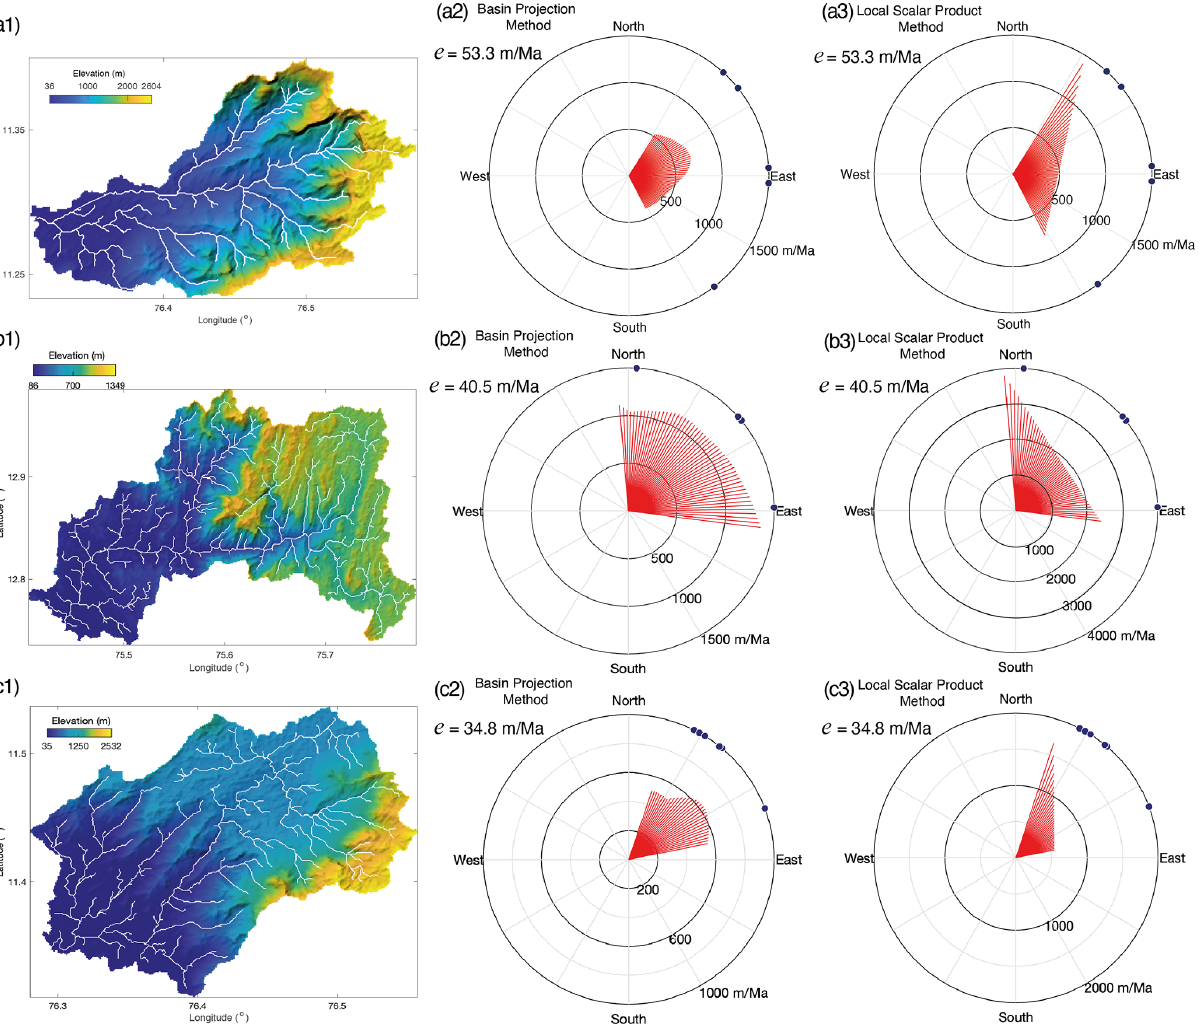
Figure 11. Example basins from the Western Ghats showing the retreat rate as a function of azimuth of a horizontal mass flux vector using (a2, b2, c2) the basin projection method; (a3, b3, c3) the local scalar product method. The azimuth of the red lines denotes the assumed escarpment retreat direction, and the length of the radial vector is the consequent retreat rate for that direction and the measured 10 Be concentration. Black dots are orientations of characteristic tributaries of the escarpment-draining channels of this